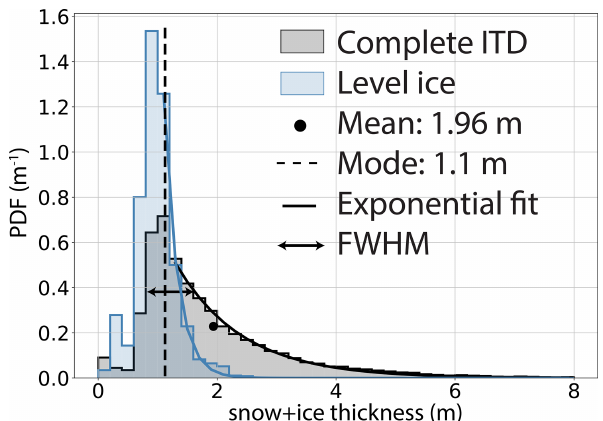
Figure 3. Ice thickness distributions (ITDs) displaying snow and ice thickness and observed by AEM on 30/31 March. ITD over the entire area of the refrozen polynya (black) and ITD of the level ice only (blue). Mean, mode, exponential fit, and FWHM are indicated for the former case. Ice thicker than 8m was observed for less than 1% of the refrozen polynya